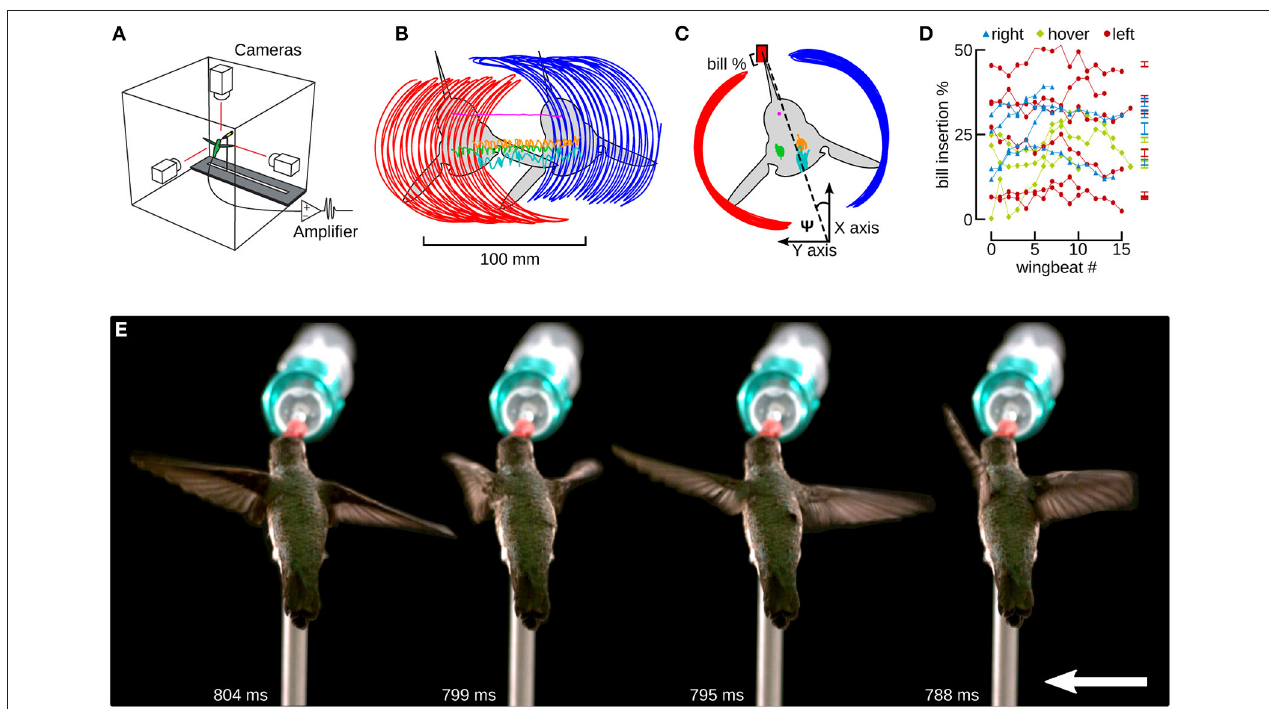
FIGURE 4 | Hummingbirds track a feeder moving laterally by inserting their bill by a similar amount as during hovering flight. (A) Hummingbird feeder tracking was studied in an acrylic flight chamber. The feeder was moved left and right using a stepper motor and linear slide. Three high-speed cameras were placed orthogonally and filmed the bird during hovering and feeder tracking. Trailing EMG electrodes were connected to an extracellular amplifier just outside of the chamber. (B) A top view of a bird moving laterally to the left. Six digitized anatomical features are presented in this panel: left wingtip (red), right wingtip (blue), left shoulder (green), right shoulder (orange), head (magenta), and tail (cyan). The colors red and blue indicate left and right in Figures 4 – 6 . (C) The frame of reference was transformed by aligning every frame to the head, and every wing stroke to the midpoints between the stroke transitions. The travel angle 9 is the angle between the wingtip path dividing line and the orientation of the feeder, which is aligned with the x-axis. 9 is positive when the bird is facing the direction of motion and negative when it is facing away. The bill % is the percentage of the exposed culmen inserted into the feeder. (D) The bill insertion percentages are plotted for all hovering (green), and left (red) and right (blue) lateral flight trials. (E) A time lapse of images from one wingbeat during feeder tracking to the left are spread out for clarity. The downstroke begins at 788ms (white text) and the mid-downstroke occurs at 795ms. The upstroke begins at 799ms and the mid-upstroke occurs at 804ms. The distance between each pair of images is equivalent to the distance the bird and feeder would move over 20 wingbeats. The feeder was moving at 15 cm/s. The entire video from which this sequence is obtained is available in the online Supplementary Materials ( Video S1